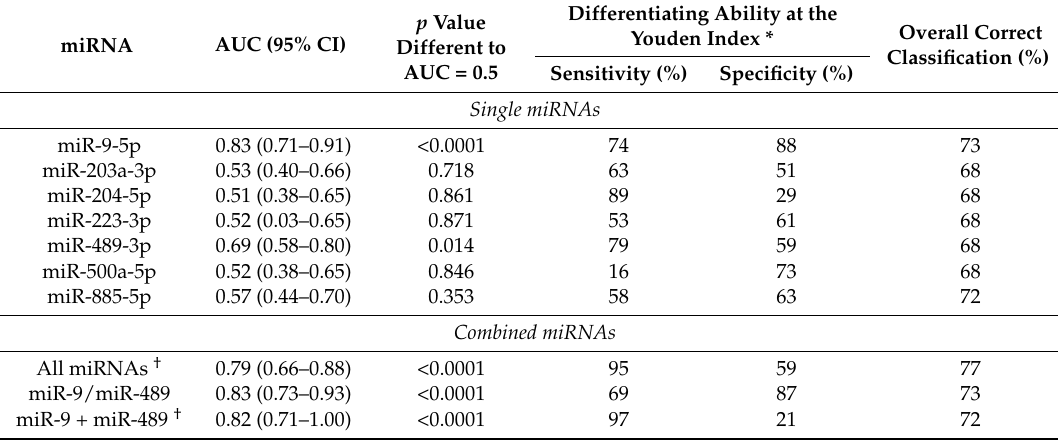
Table 2. Receiver-operating characteristic curve analyses of miRNAs in nephrectomized tumor tissue samples to discriminate between patients as responders and non-responders to the treatment with tyrosine kinase